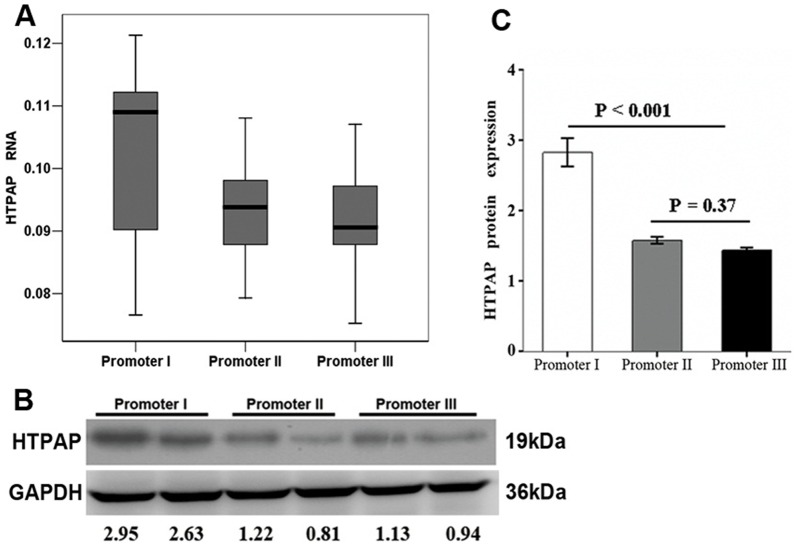
The analysis of HTPAP expression levels by qRT-PCR and western blotting in the groups of HCC specimens with promoter I, II and III haplotypes.The HTPAP mRNA levels in the group of HCC specimens with promoter II and III haplotypes were significantly lower than those with promoter I (p<0.001) according to qRT-PCR. However, no significant difference was found between the promoter II and promoter III haplotype groups (p = 0.134)(A). Western blotting demonstrated that the HTPAP protein expression level in the HCC samples with promoters II+III was significantly lower than that with promoter I (p<0.001). There was no significant difference between samples with promoter II and those with promoter III (p = 0.37)(B,C).